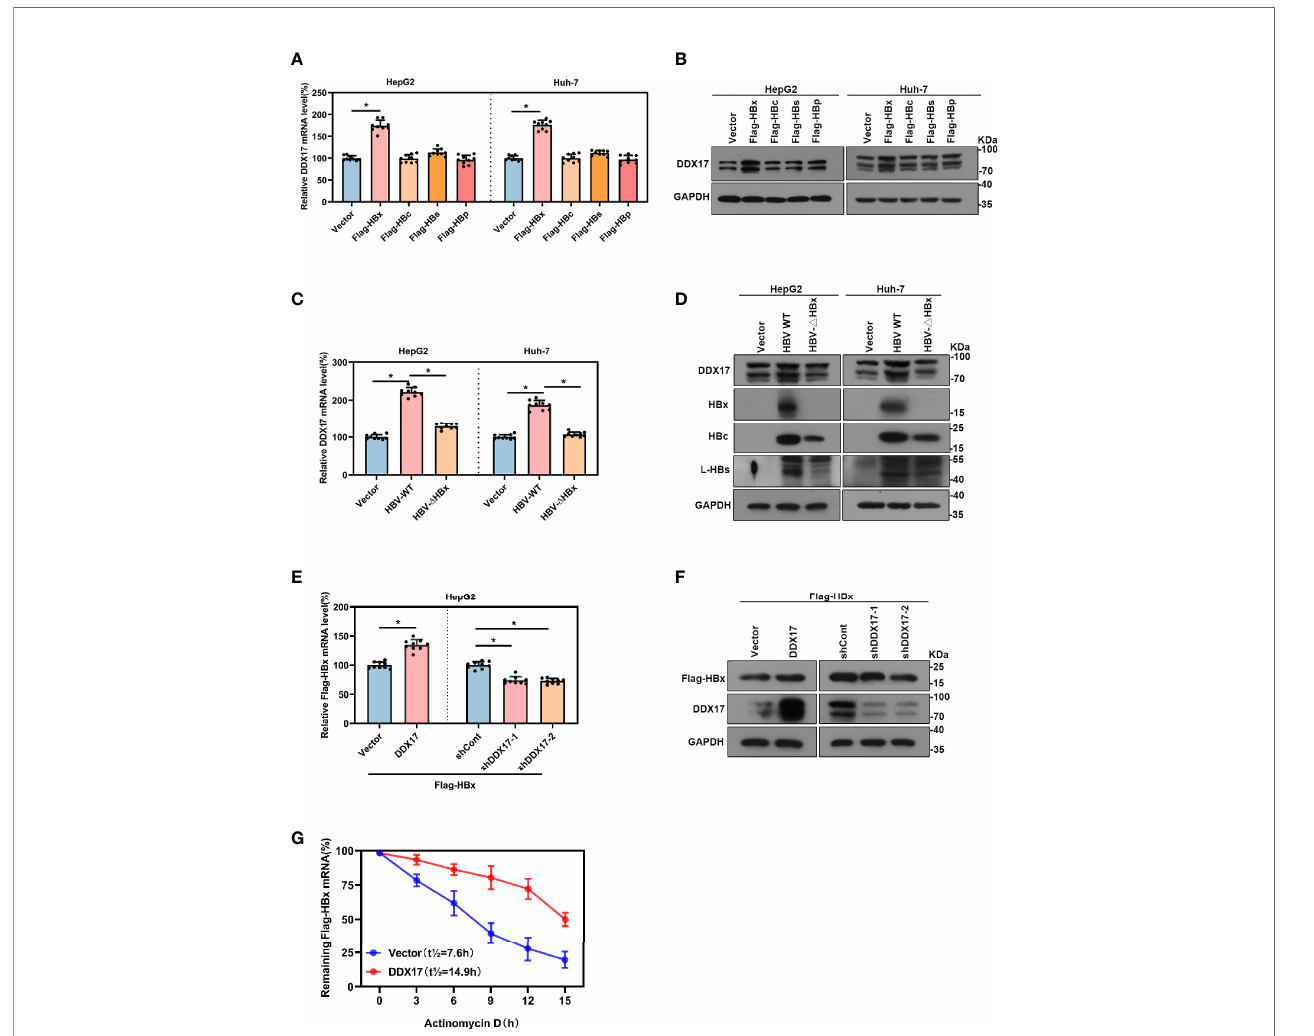
FIGURE 3 | There was a positive correlation between Viral protein HBx and DDX17. (A, B) The vector, Flag-HBx, Flag-HBc, Flag-HBs or Flag-HBp plasmids were transfected into HepG2 cells and Huh-7 cells. Real-time PCR and Western blot examined the mRNA and protein levels of DDX17. b -actin and GAPDH were used as the internal quantitative controls respectively. (C, D) The vector, HBV WT or HBV- D HBx plasmids were transfected into HepG2 and Huh-7 cells. Real-time PCR examined the mRNA evels of DDX17 and Western blot examined the protein levels of DDX17, HBx, HBc and HBs. b -actin and GAPDH were used as the internal quantitative controls, respectively. (E, F) The vector or DDX17 plasmids were co-transfected with Flag-HBx into the HepG2 cells; the short hairpin RNAs targeting DDX17 (shDDX17-1 and shDDX17-2) or nontargeting shRNA (shCont) were co-transfected with Flag-HBx into the HepG2 cells. Real-time PCR and Western blot examined the mRNA and protein levels of Flag-HBx. (G) DDX17 overexpression in HepG2 cells followed by treatment with 5ug/mL actinomycin D at the indicated times. b -actin and GAPDH were used as the internal quantitative controls, respectively. *P <